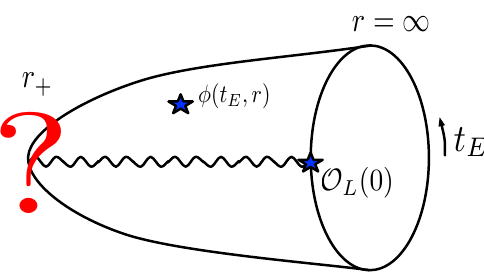
Figure 1 . This (cid:12)gure depicts a Euclidean bulk-boundary correlator in a black hole microstate. Although we have forced the correlator to live on the Euclidean BTZ geometry, due to violations of the KMS condition the correlator will be multivalued on the Euclidean time circle, and so must have a branch cut. Thus semiclassical predictions for bulk correlators must breakdown. In particular, as the Euclidean time circle shrinks to vanishing size at the horizon, it would seem that exact bulk correlators must di(cid:11)er sign(cid:12)cantly from their semiclassical limits at the Euclidean